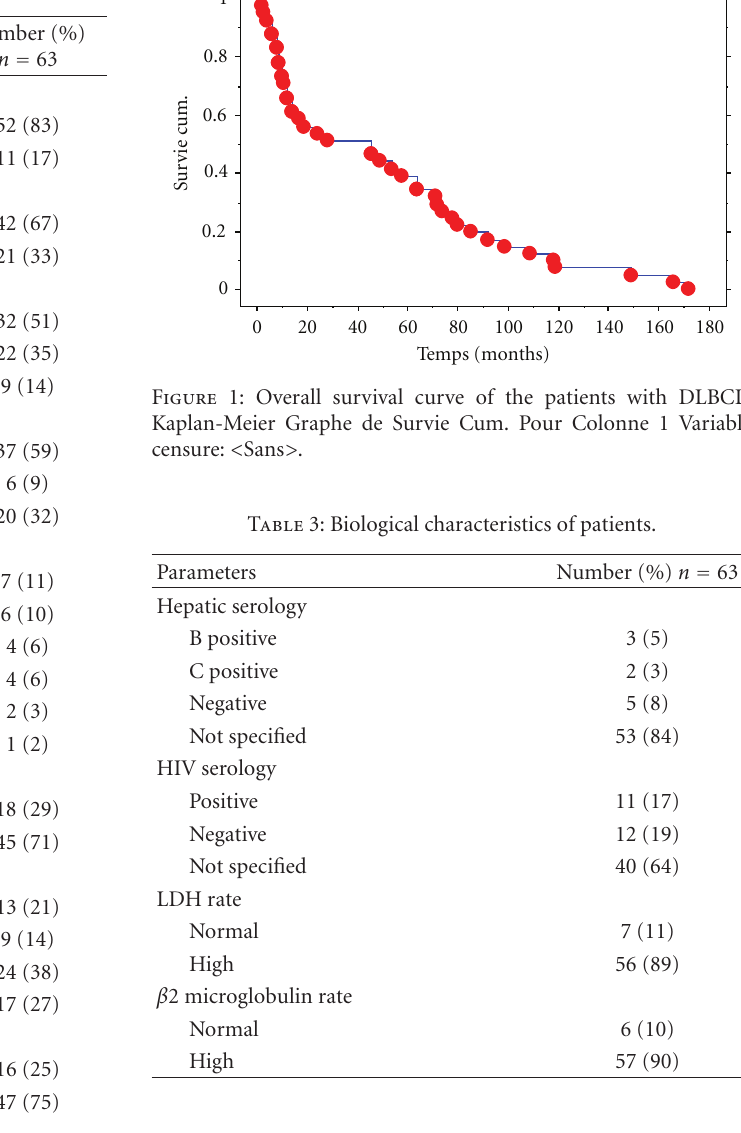
Table 2: General characteristics of patients.